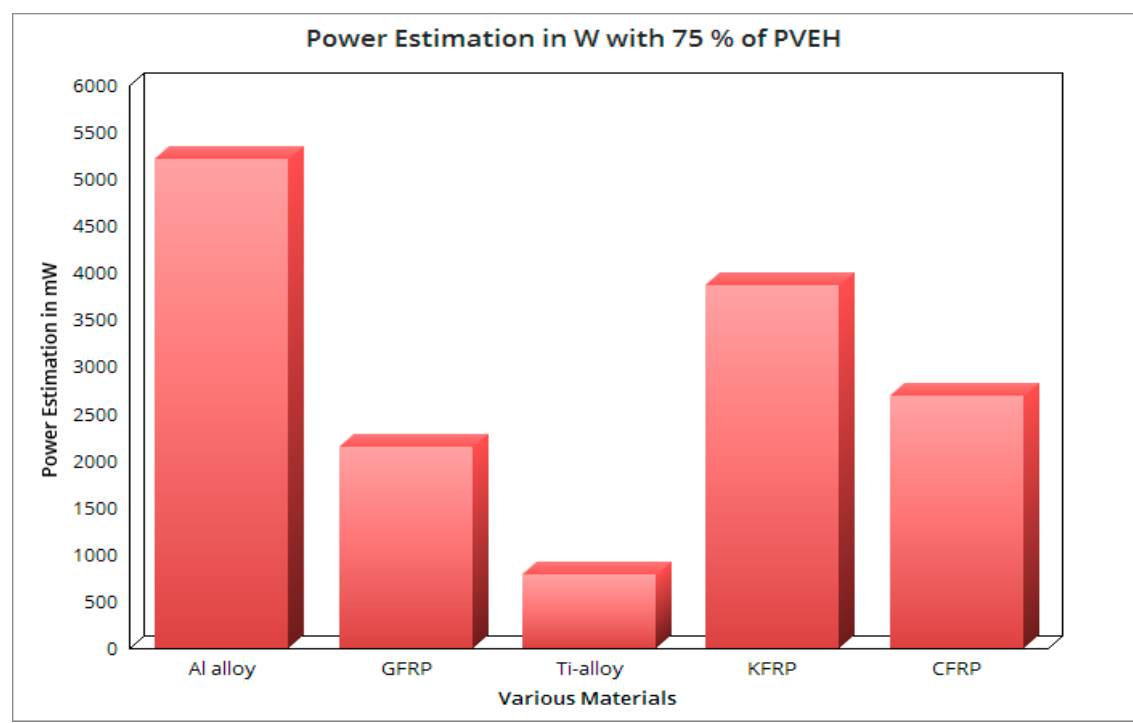
Figure 42. Power (P 0 ) in W with 50% attachment coverage-UAV wing.